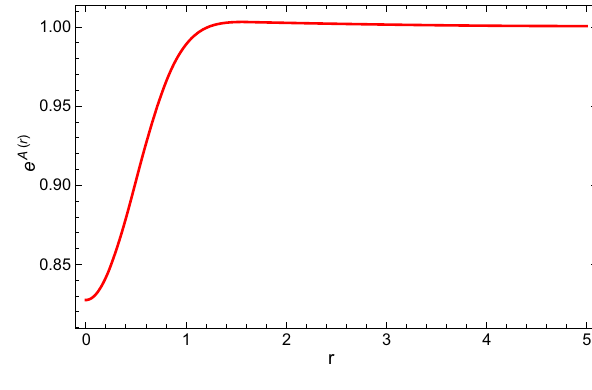
Fig. 3 p r as a function of r . The solid (blue) and dashed (red) curves correspond tothecaseswith M = 0 . 2 , θ = 0 . 1and M = 0 . 1 , θ = 0 . 1, respectively